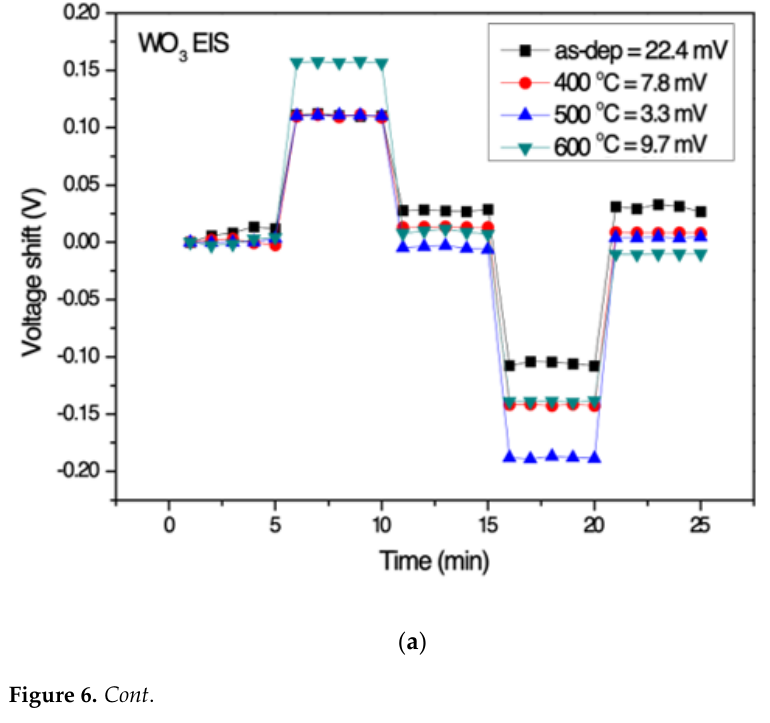
To observe how the acid-based solution affected the property of devices, the samples are soaked in solution in the order of pH7-pH4-pH7-pH10-pH7. The setup is shown in Figure 1b. The hysteresis is the voltage measured for every minute. The value of the hysteresis voltages reflects the defect density on the film and the defect, affecting the gate voltage in the sensing membrane [39]. The hysteresis voltage is defined as the substrate voltage difference between the initial and terminal voltages measured in the pH loop. All the measurements are performed at room temperature. The hysteresis voltage of the WO 3 samples and Y-doped WO 3 samples based on EIS structure in different RTA temperatures are shown in Figure 6a,b. The hysteresis voltages of the WO 3 for the as-dep sample and the samples with annealing temperatures of 400, 500, and 600 ◦ C are 22.4, 7.8, 3.3, and 9.7 mV, respectively. On the other hand, the hysteresis voltage of Y-doped WO 3 for the as-dep sample and the samples with annealing temperatures of 400, 500, and 600 ◦ C are 14.4, 1.7, 9.2, and 10.1 mV, respectively. The Y-doped WO 3 sensing film annealed at 400 ◦ C has the lowest hysteresis voltage. Furthermore, compared with the samples without Y doping, a significant decrease in hysteresis voltage can be observed after Y doping, for Y doping suppresses the defects and inhibits the formation of oxygen vacancies. Therefore, the function of membrane capacitance can be ameliorated as shown in Equations (1)–(3). The results are consistent with XPS analysis and XRD patterns.